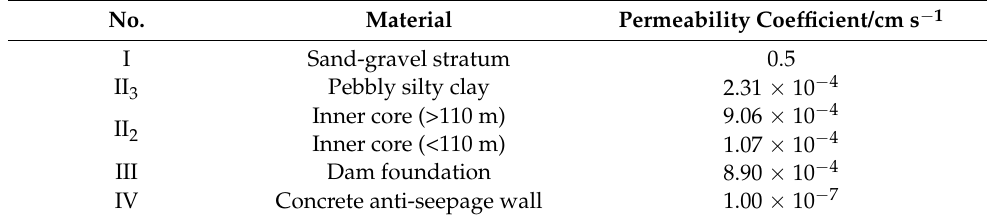
Table 2. Characteristics of the materials for the main dam.